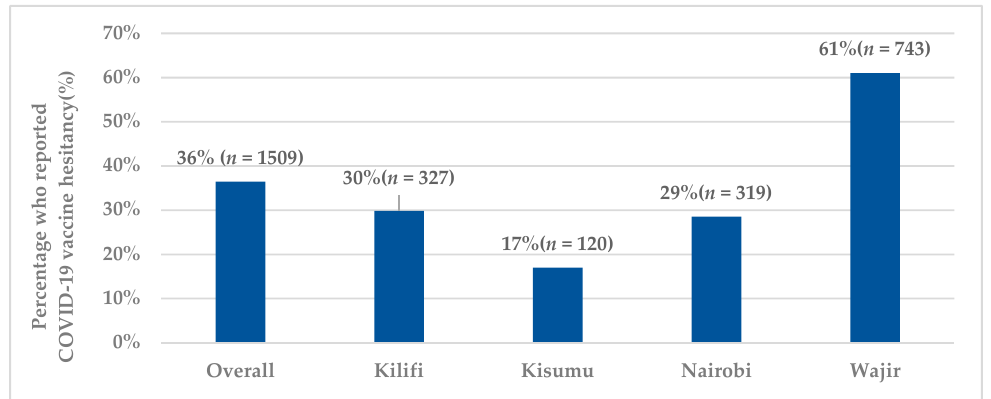
Figure 1. Level of vaccine hesitancy across study counties.